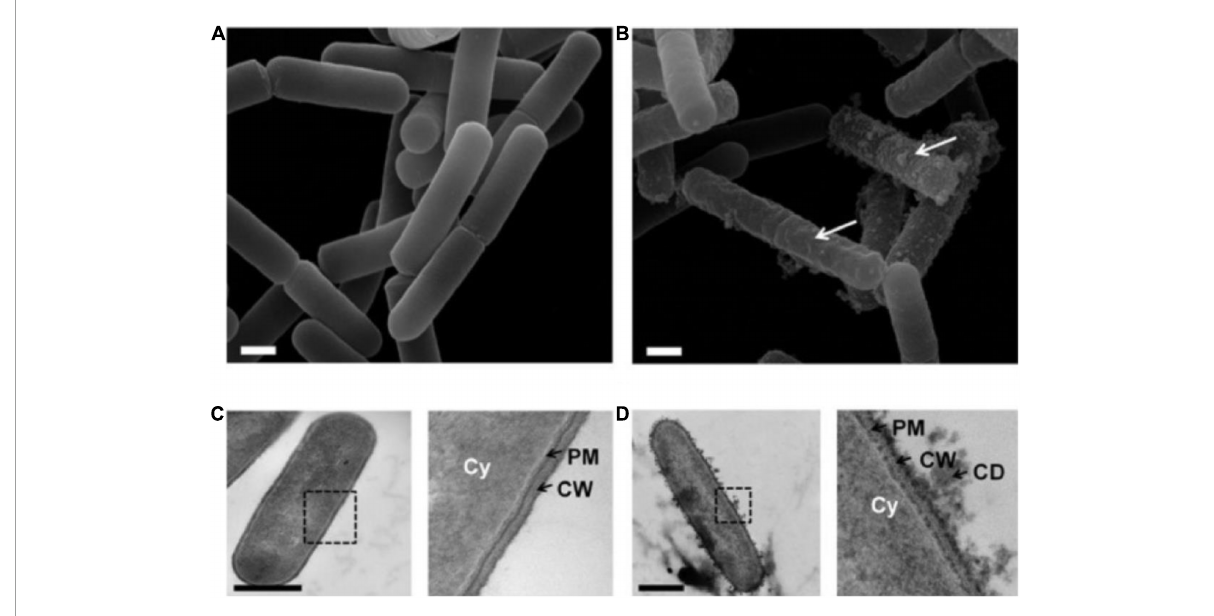
FIGURE3 (A) SEM image of untreated bacteria. (B) After exposure to PEF (7.5 kV/cm, 1 ms), the SEM image showed bacterial surface damage. (C) TEM image of untreated Bacillus pumilus . Cy, cytoplasm; PM, plasma membrane; CW, cell wall. (D) TEM image of Bacillus pumilus after PEF. The illustration revealed the discharge of cell debris (CD) and the damage to PM and CW. Scale bars, 500 nm. Reprinted from Davaux et al.